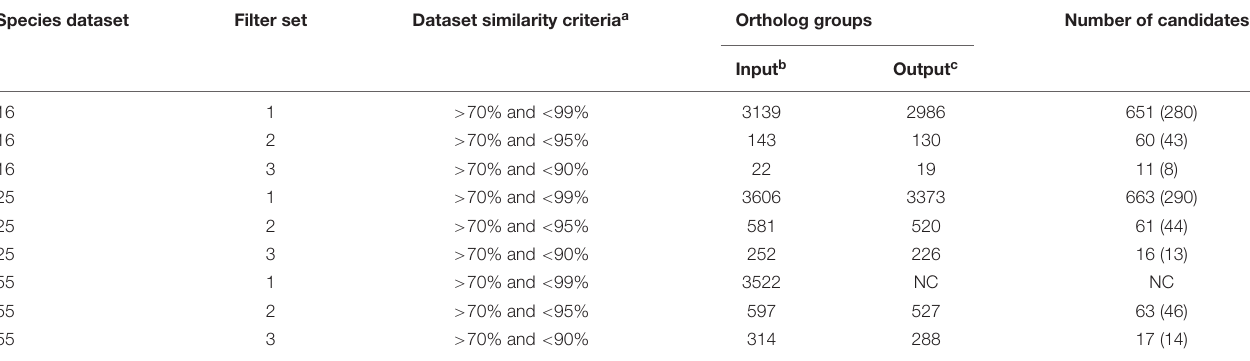
TABLE 3 | Number of ortholog groups per dataset and the number of predicted candidates. Species dataset Filter set Dataset similarity criteria a Ortholog